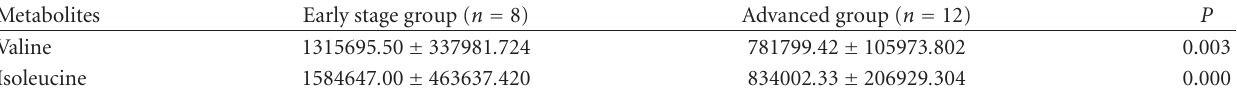
Table 3: Di ff erent metabolites identified in early stage group and advanced group (mean ± SD).